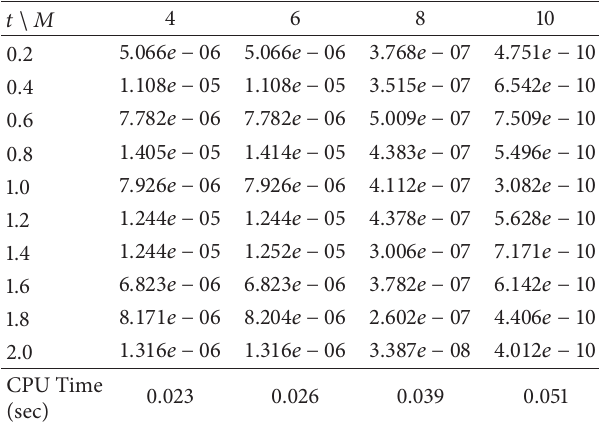
Table1:Maximumerrors 𝐸 𝑁 forFisher’sequationwhen 𝛼 = 1 using ℎ = −0.9 .